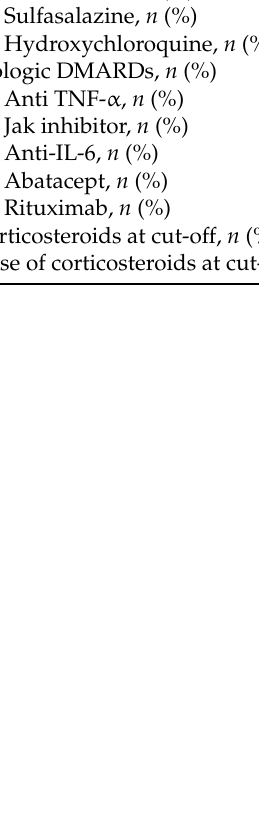
Table 2. cIMT study and inflammatory cytokine profile for 75 patients with RA and 67